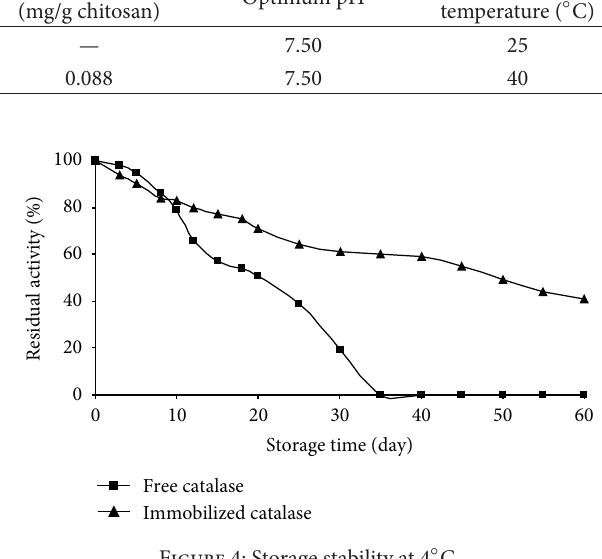
F 2: Effect of pH on activity.